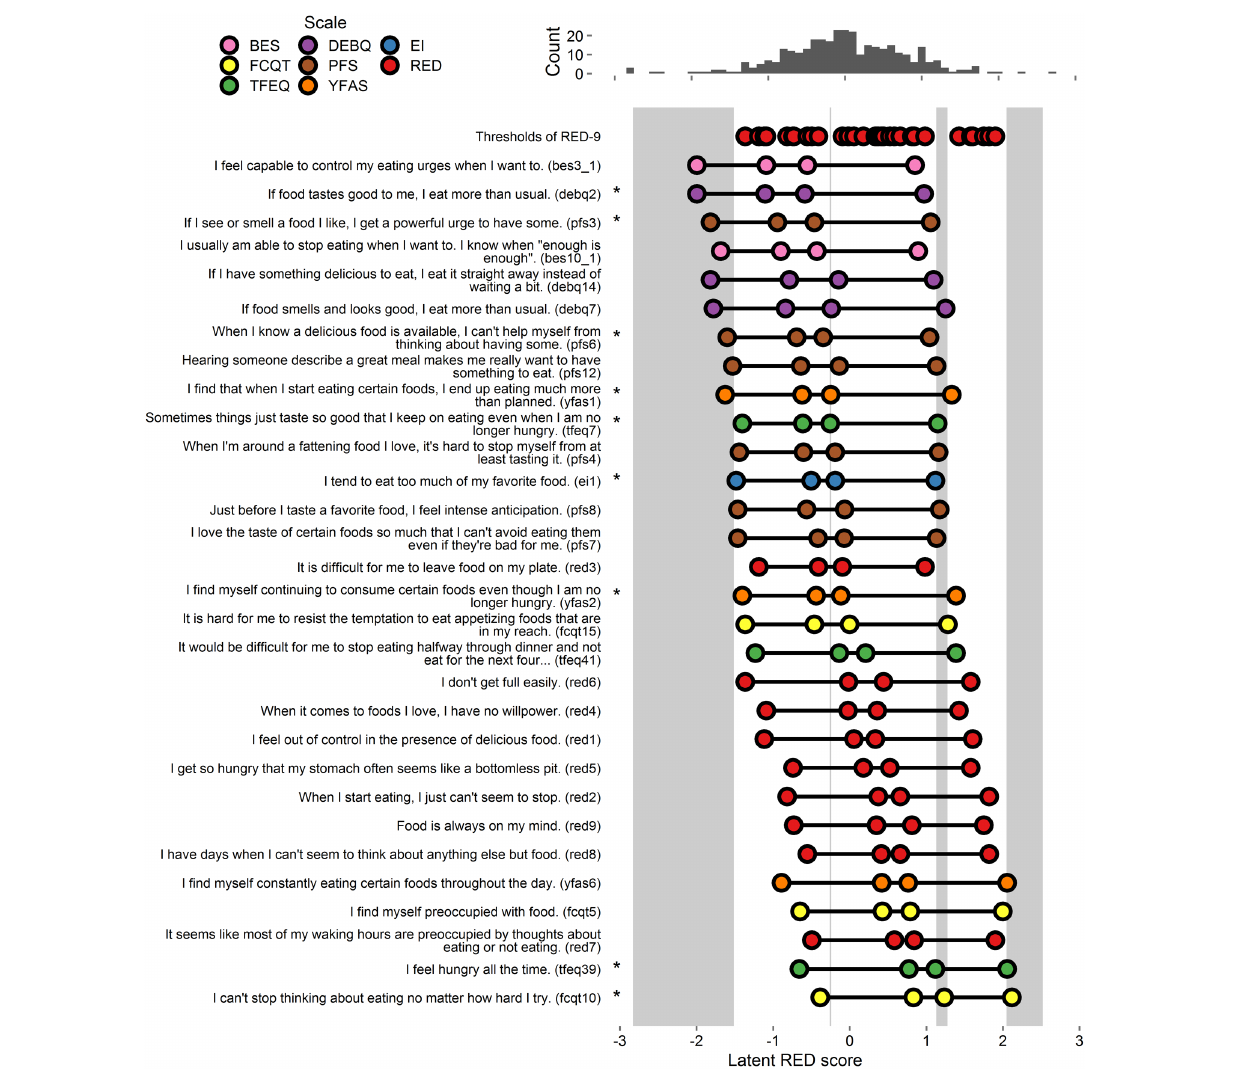
FIGURE 3 | Person-item map and histogram depicting thresholds on the spectrum of RRE for Study 3. See Figure 1 note. This figure includes the RED-9 items the 21 items that account for variance in the gap areas. For a graph on all items tested, see Supplementary Figure S3 . Stars indicate items selected by authors for inclusion in Study